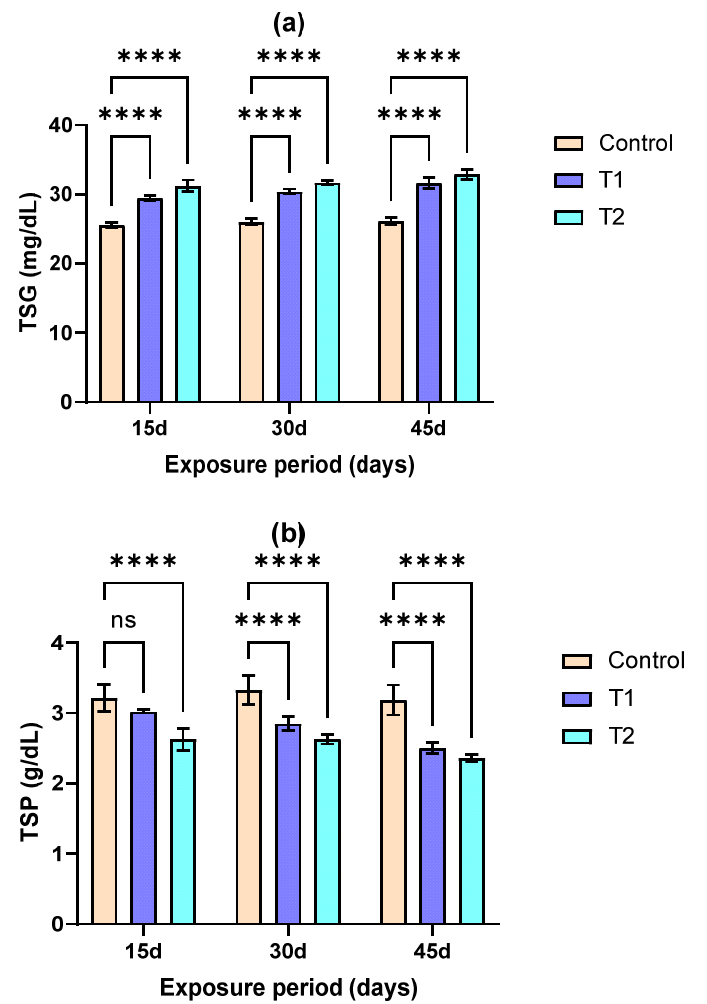
Figure 4. ( a , b ) Mean and SD values of different biochemical parameters of Clarias batrachus exposed to different concentrations of diazinon (0.64 and 1.28 mg/L) for different exposure times (15, 30, and 45 days). *—denotes significant differences to control within the same exposure time (**** p < 0.0001); TSG—total serum glucose, TSP—total serum protein.